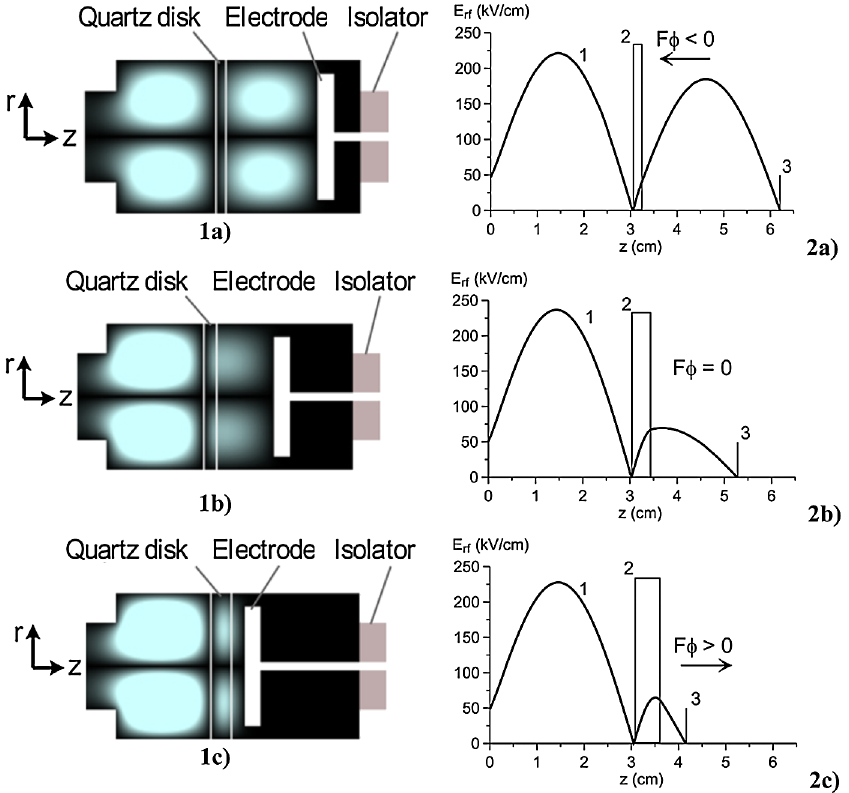
FIG. 3. (Color) Instantaneous distribution of the microwave field in the resonator for disks having different thicknesses (1a— d 1 ¼ ¼ 4 : 2 mm , 1c— d ¼ 6 mm ) and (2a–2c) dependence of the amplitude of the rf electric field at the maximum of the 2 : 3 mm , 1b— d 2 3 TE 012 mode on the longitudinal coordinate for an incident power of 100 kW. 1—amplitude of the rf field, 2—quartz disk, 3— electrode (back wall of the